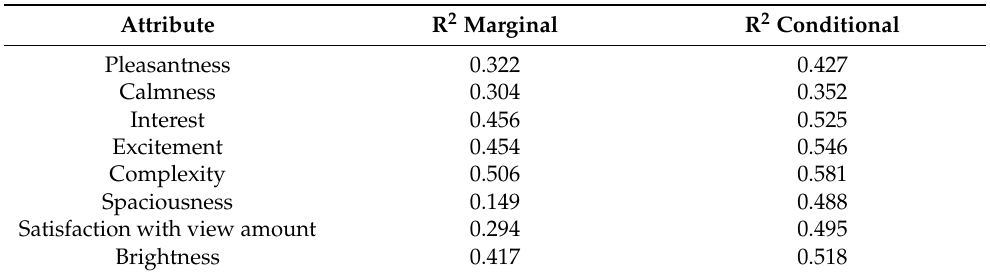
Table 4. Results of the LMM analysis for the main factors of aperture design, window size and sky type on all dependent